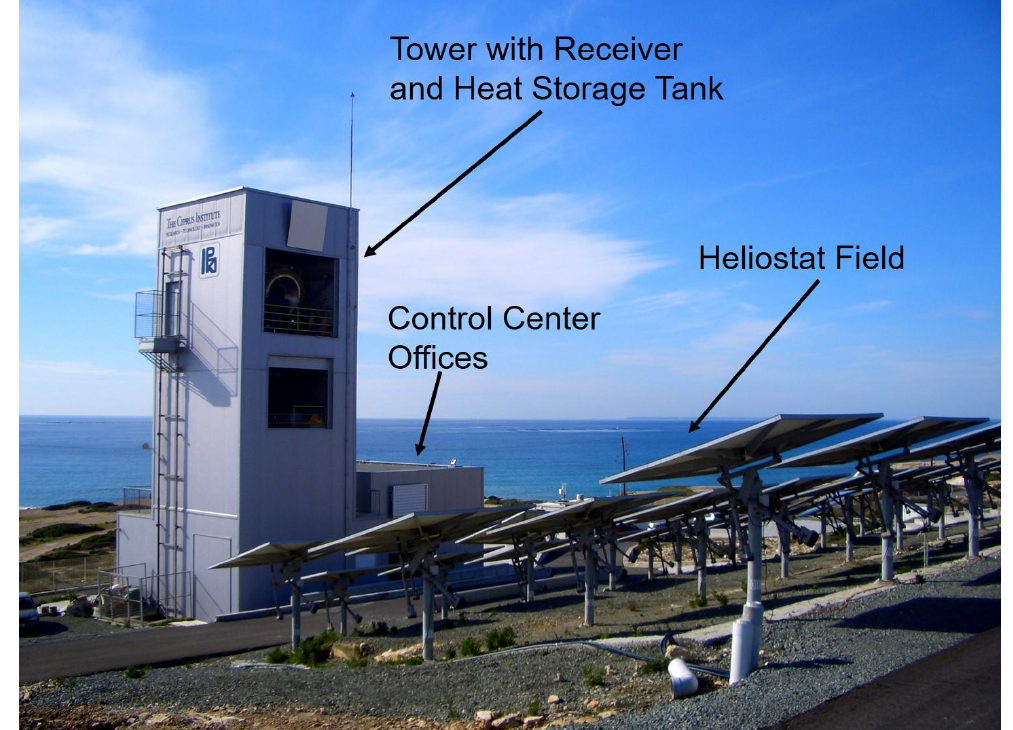
Figure 9. The PROTEAS CSP field facility of the Cyprus Institute (see above; photograph: M. Lange).